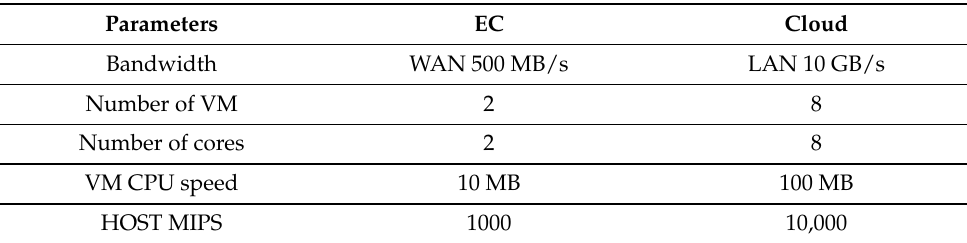
Table 7. Simulation